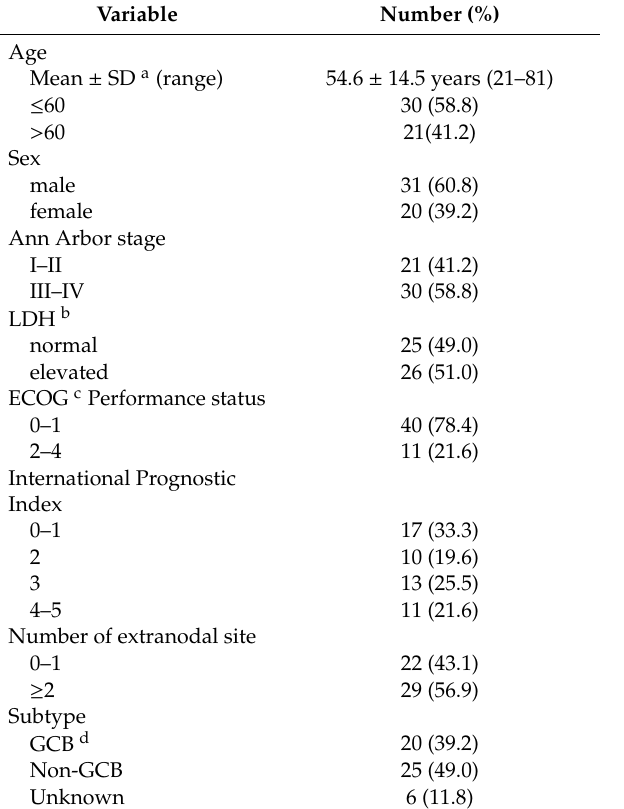
Table 1. Patient demographics ( n =